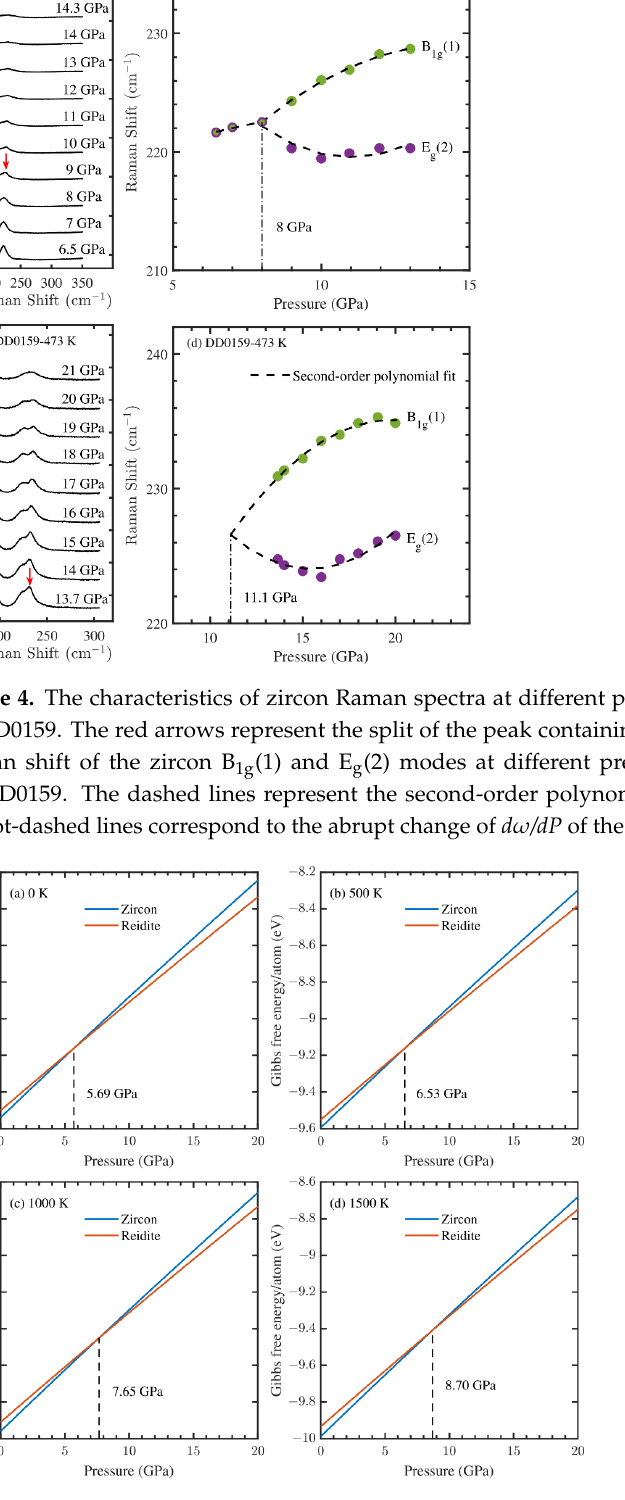
Figure 5. The Gibbs free energy of zircon and reidite unit cells as a function of pressure at 0 K ( a ), 500 K ( b ), 1000 K ( c ) and 1500 K ( d ). The vertical dashed lines correspond to the phase transition pressures.